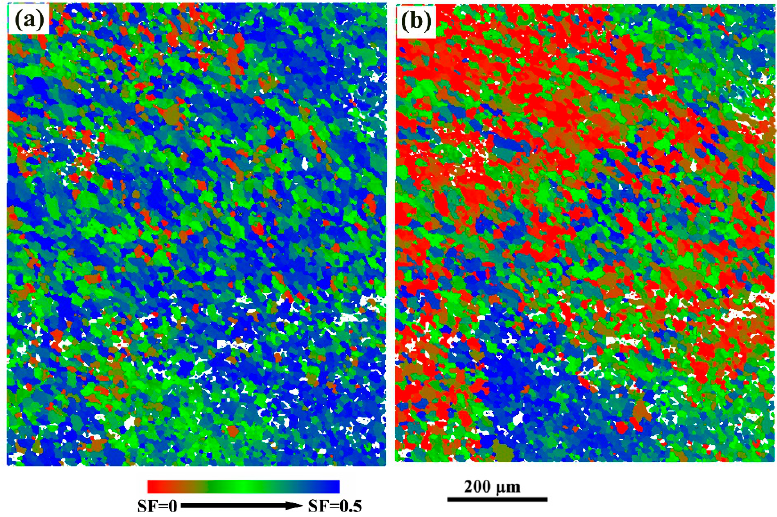
Figure 7. SF maps of triple junction region in FSW AZ31 alloy during the transverse tensile tests: ( a ) SF map for basal slip; and ( b ) SF map for extension twinning.